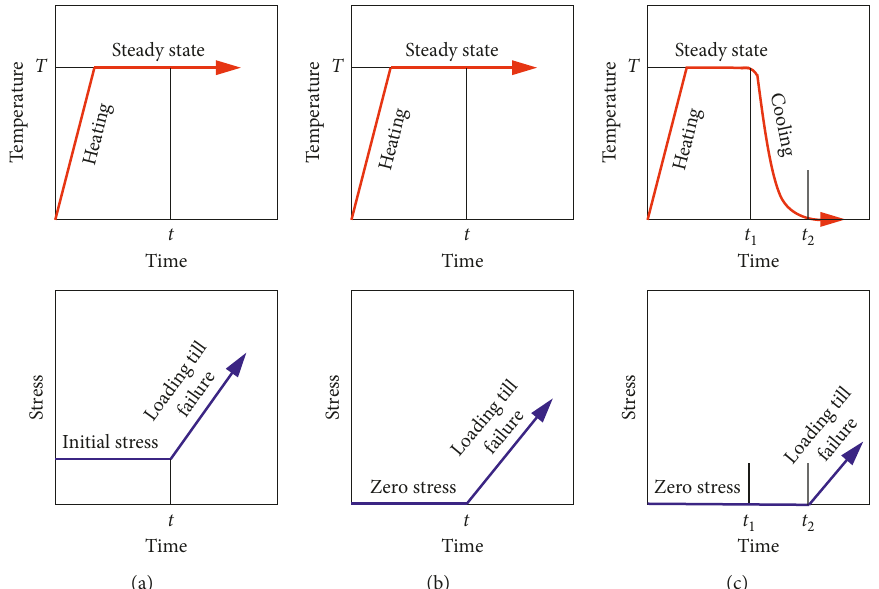
Figure 1: Schematic of temperature and loading histories for the three test methods [16]. (a) Stressed test. (b) Unstressed test. (c) Residual